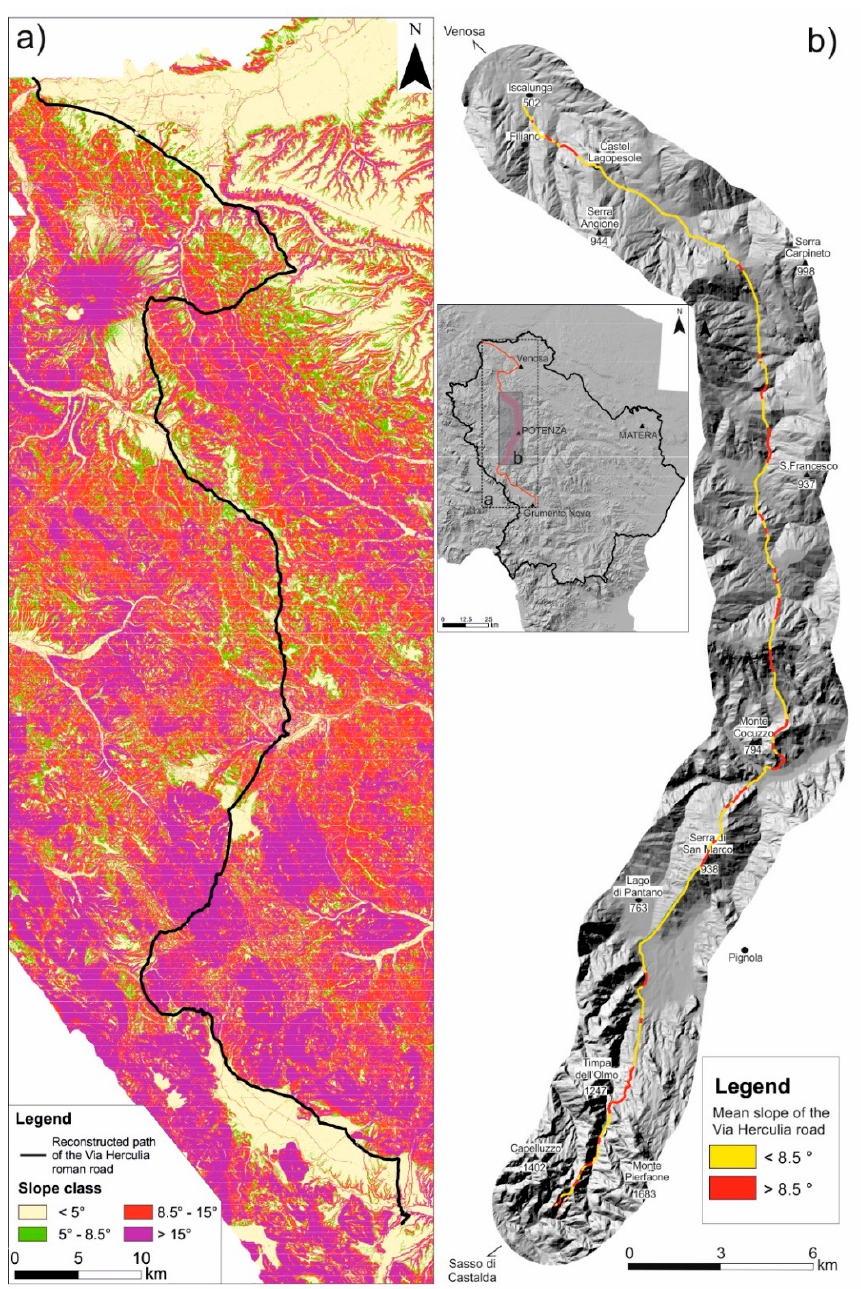
Figure 9. ( a ) Slope map of the study area; ( b ) hillshade of the study area and mean slope of the Via Herculia. Herculia